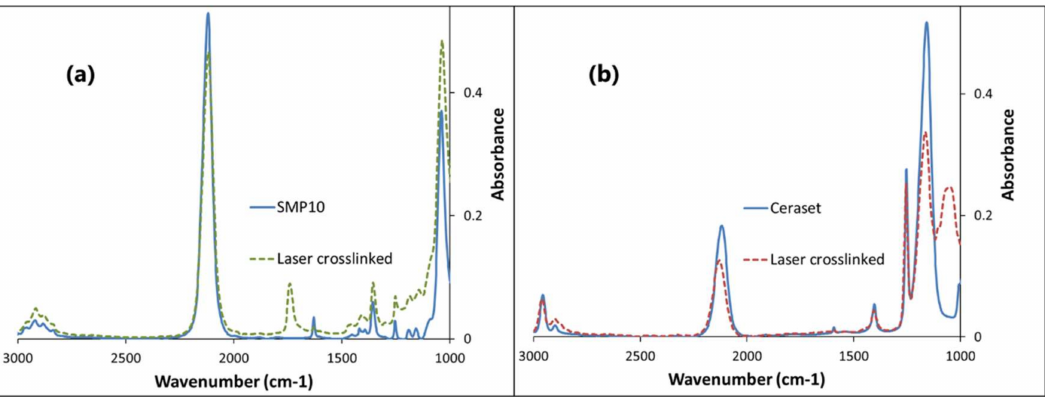
Figure 5. ATR-IR of SMP10 ( a ) and Ceraset ( b ) before (solid blue curves) and after crosslinking (dashed